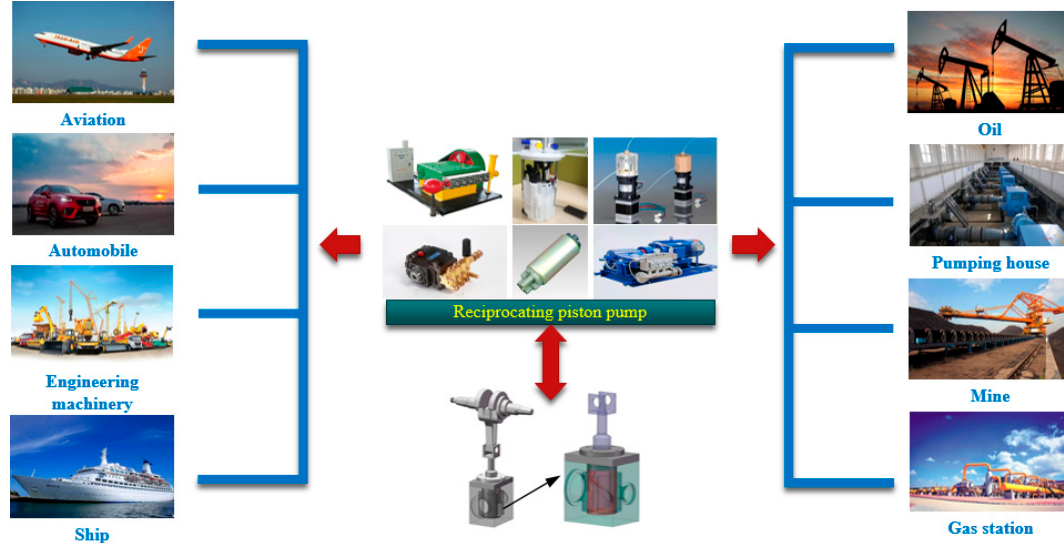
Figure 1. Applications of the reciprocating piston pump.